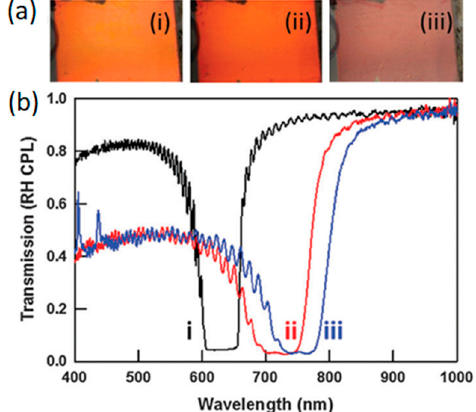
Figure 12. ( a ) Reflection images of PSCLC prepared with 1 wt.% Irgacure 369 at (i) 0 V, (ii) during application of 20 V DC and (iii) UV exposure during application of 20 V DC. ( b ) Transmission spectra at (i) 0 V, (ii) during application of 40 V DC, and (iii) during application of 40 V DC in the presence of 50 mW cm − 2 of UV light. Adapted from ref. [78].